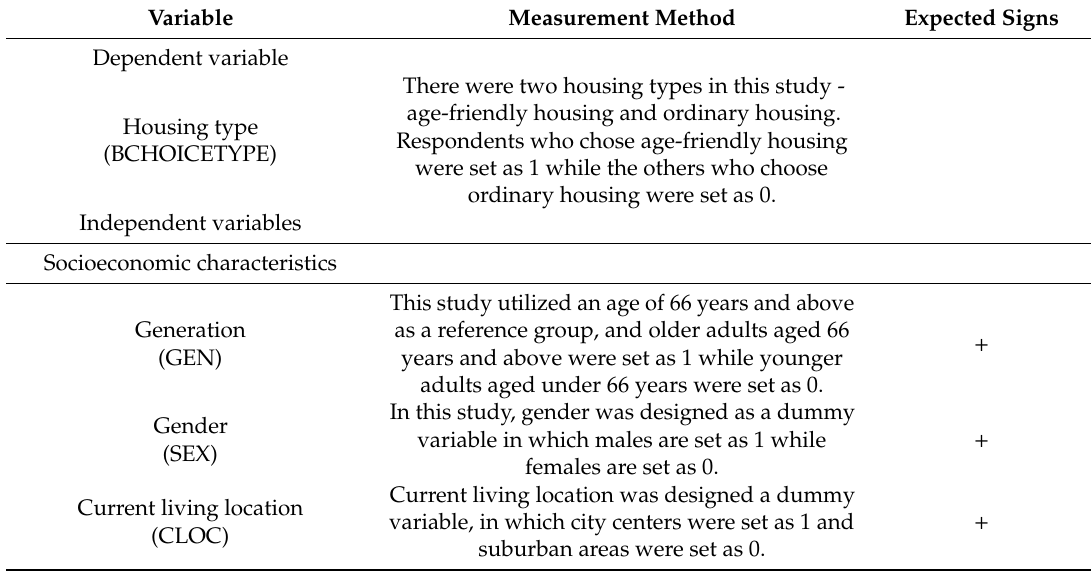
Table 1. Description of variable